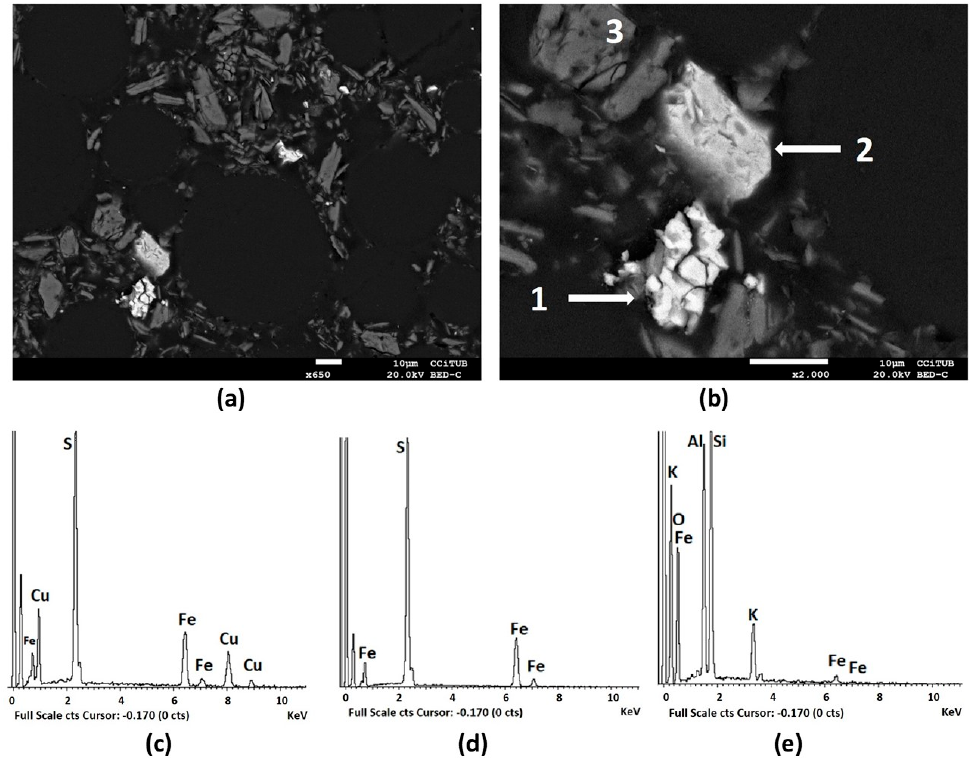
Figure 4. SEM image of the initial sample at various magnifications: ( a ) × 650, ( b ) × 2000. In ( b ), 1: chalcopyrite, 2: pyrite, and 3: muscovite. EDS analysis in ( c ) of chalcopyrite, in ( d ) of pyrite, and in ( e ) of muscovite.